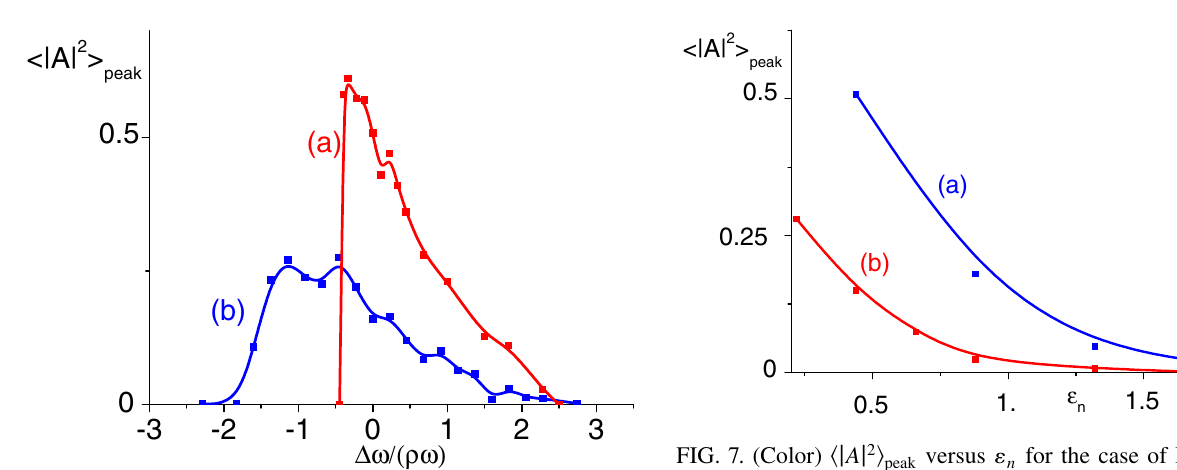
FIG. 6. (Color) hj A j 2 i versus (cid:4) != (cid:2) !(cid:9) (cid:3) for the case of Fig. 5 peak (cid:4) 0 : 44 (cid:11) m and (b) " (cid:4) 0 : 88 (cid:11) m . and (a) " n n